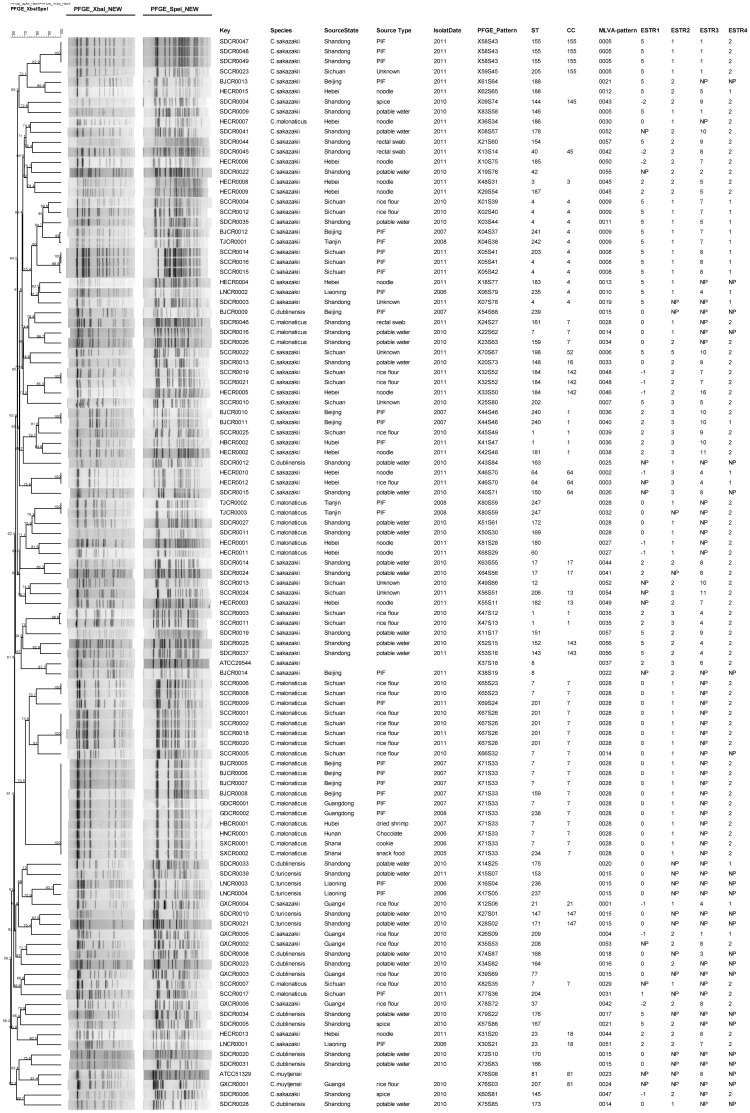
Dendrogram combining PFGE patterns of XbaI- and SpeI- digested DNA from Cronobacter spp. in this study.Isolates information, STs, CC and MLVA allele string are also included.